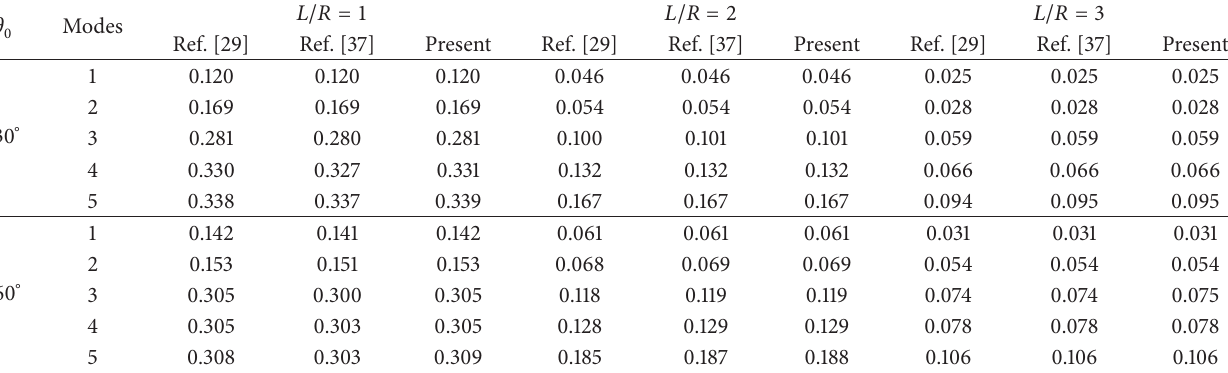
Table 4: Comparison of the first five nondimensional frequency parameters Ω = 𝜔𝑅√𝜌/𝐸 for an open cylindrical shell with C-F-C-F boundary condition.